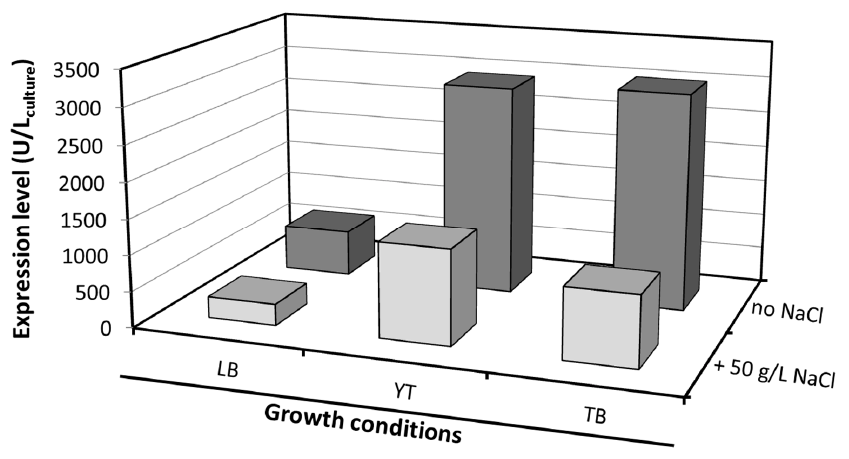
α -HSDH in di ff erent